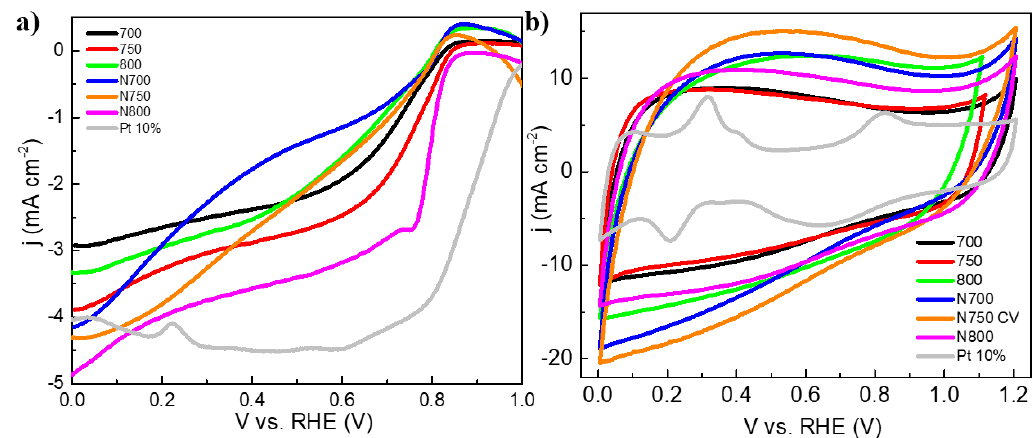
Figure 6. ( a ) Linear sweep voltammetry (LSV) assessment of metal-free electrocatalysts at 2000 rpm and a 5 mV s − 1 scan rate in O 2 -saturated 0.5 M KOH solution and ( b ) cyclic voltammetry (CV) in N 2 -saturated alkaline electrolyte (0.5 M KOH) at a 20 mV s − 1 scan rate. Table 5. Electrocatalytical parameters of the oxygen reduction reaction (ORR) performance. Electrocatalysts Current Density (mA cm − 2 at 0.0 V) Onset Potential (V vs.